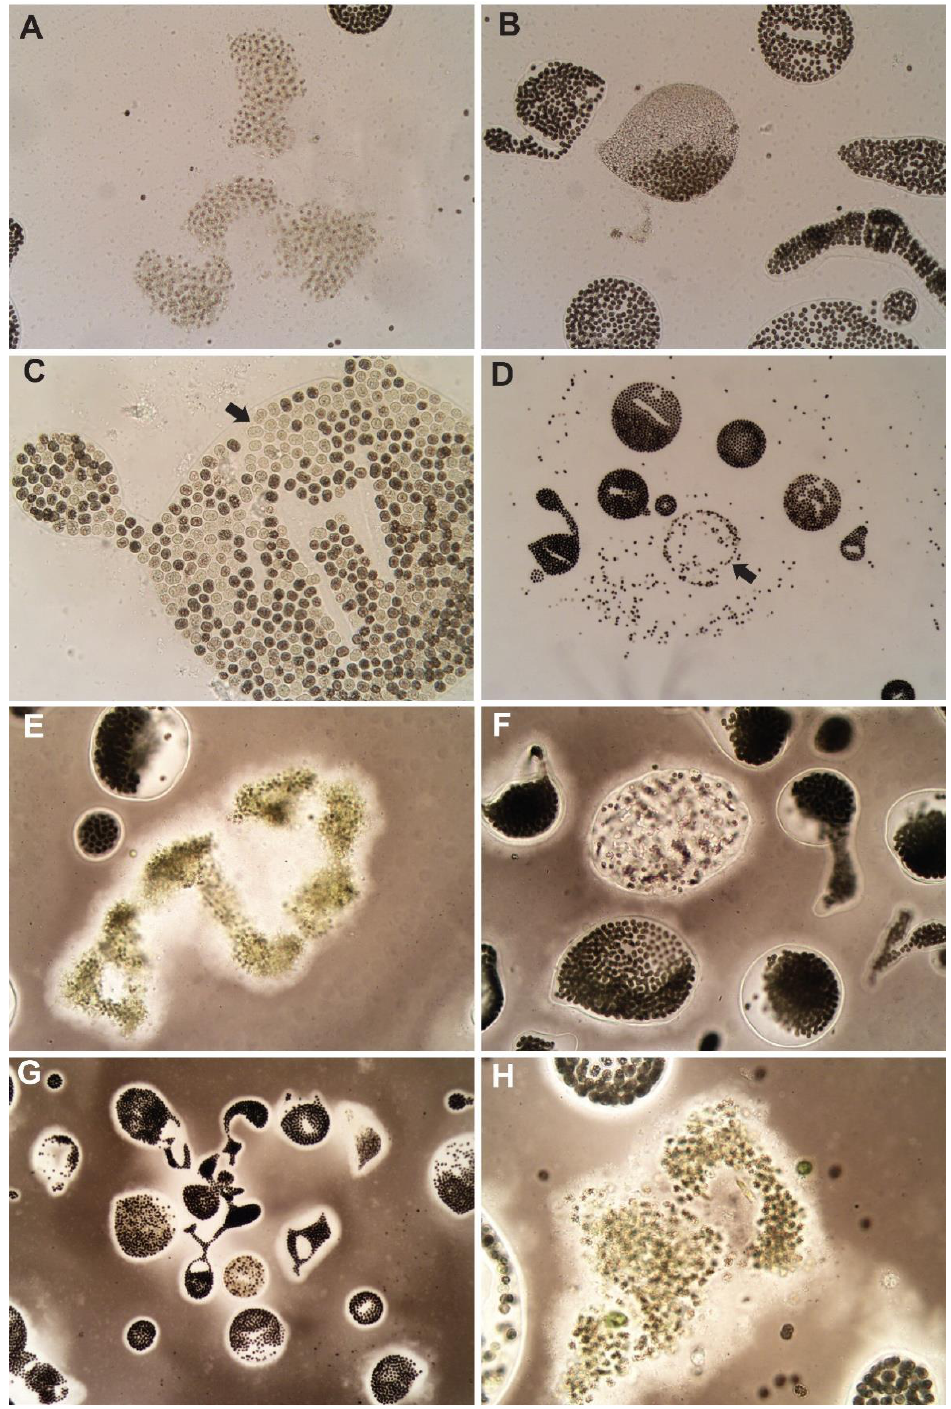
Figure 3. Microcystis colonies 72 h post-treatment with peroxide-based algaecides. GreenClean ® Liq- uid 5.0: ( A ) dead M. aeruginosa colonies, ( B ) M. wesenbergii colony breakdown and death. GreenClean ® Pro: ( C ) M. wesenbergii colony bleaching, arrow indicates bleached cells, ( D ) M. wesenbergii colony breakdown and cell bleaching, arrow indicates colony breakdown. PAK ® 27: ( E ) dead M. aeruginosa colony, ( F ) dead M. wesenbergii colony. Phycomycin ® SCP: ( G ) M. wesenbergii colony breakdown and bleaching, ( H ) dead M. aeruginosa